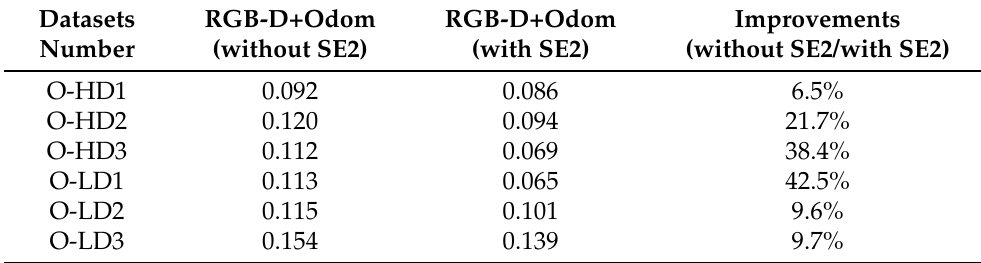
Table 2. Positioning accuracy comparison between with SE(2) and without SE(2) (unit: